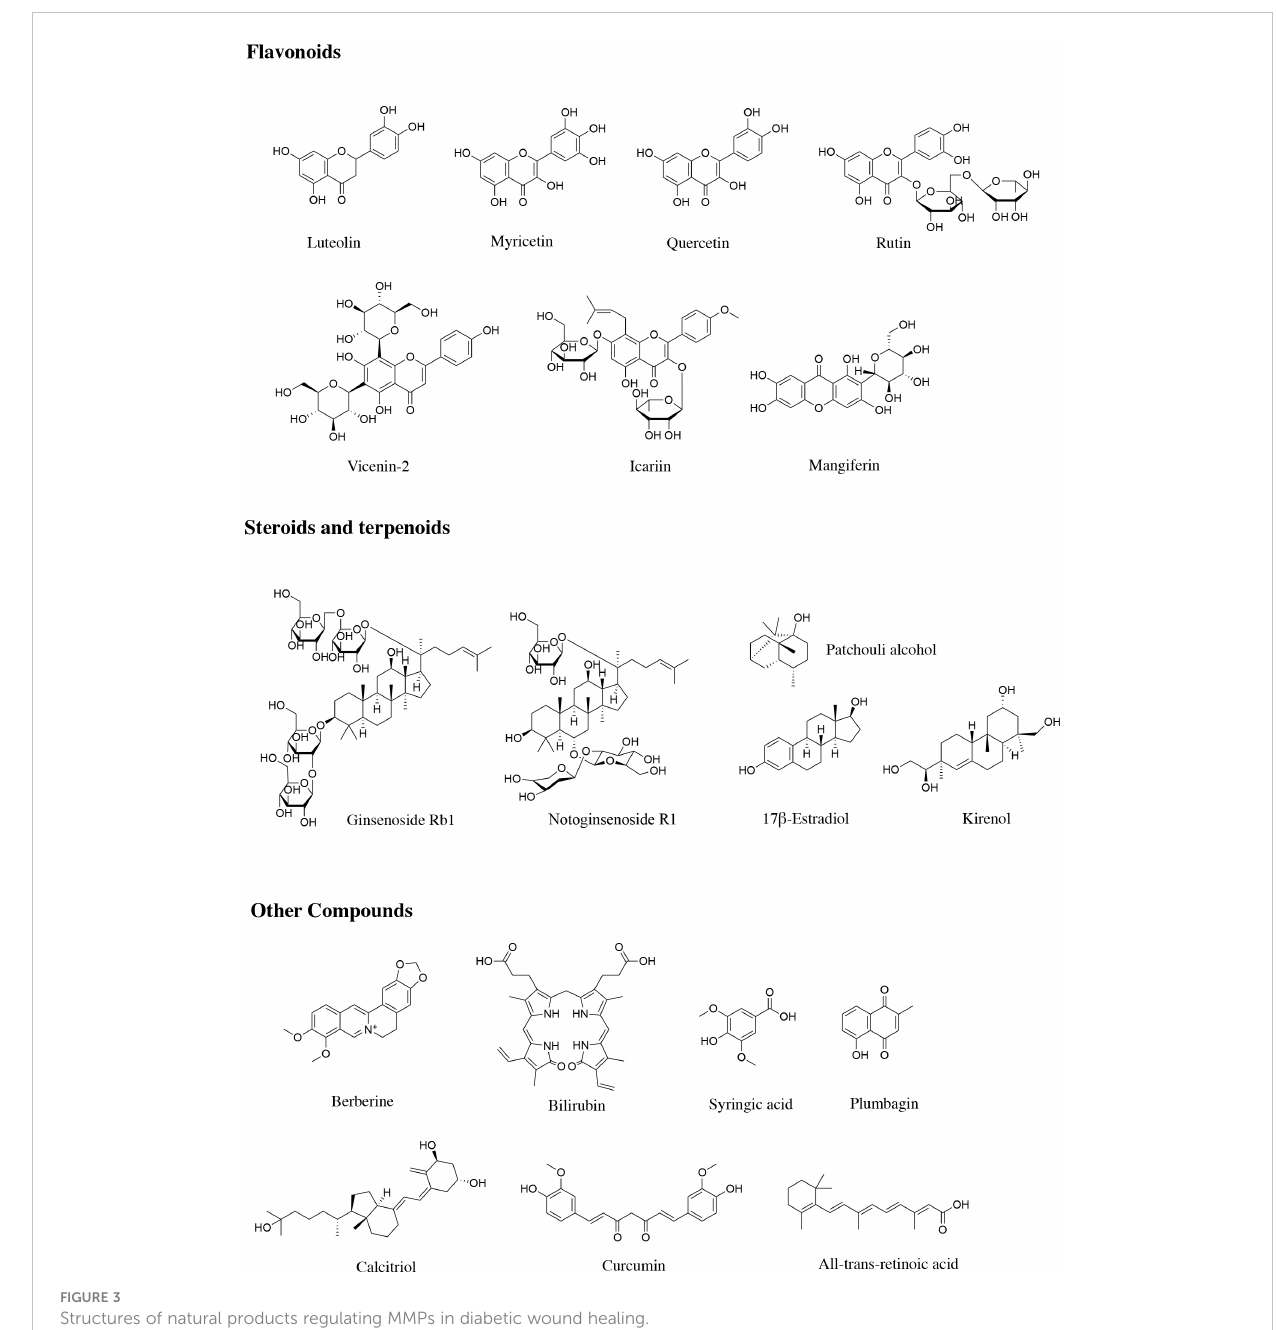
FIGURE 3 Structures of natural products regulating MMPs in diabetic wound